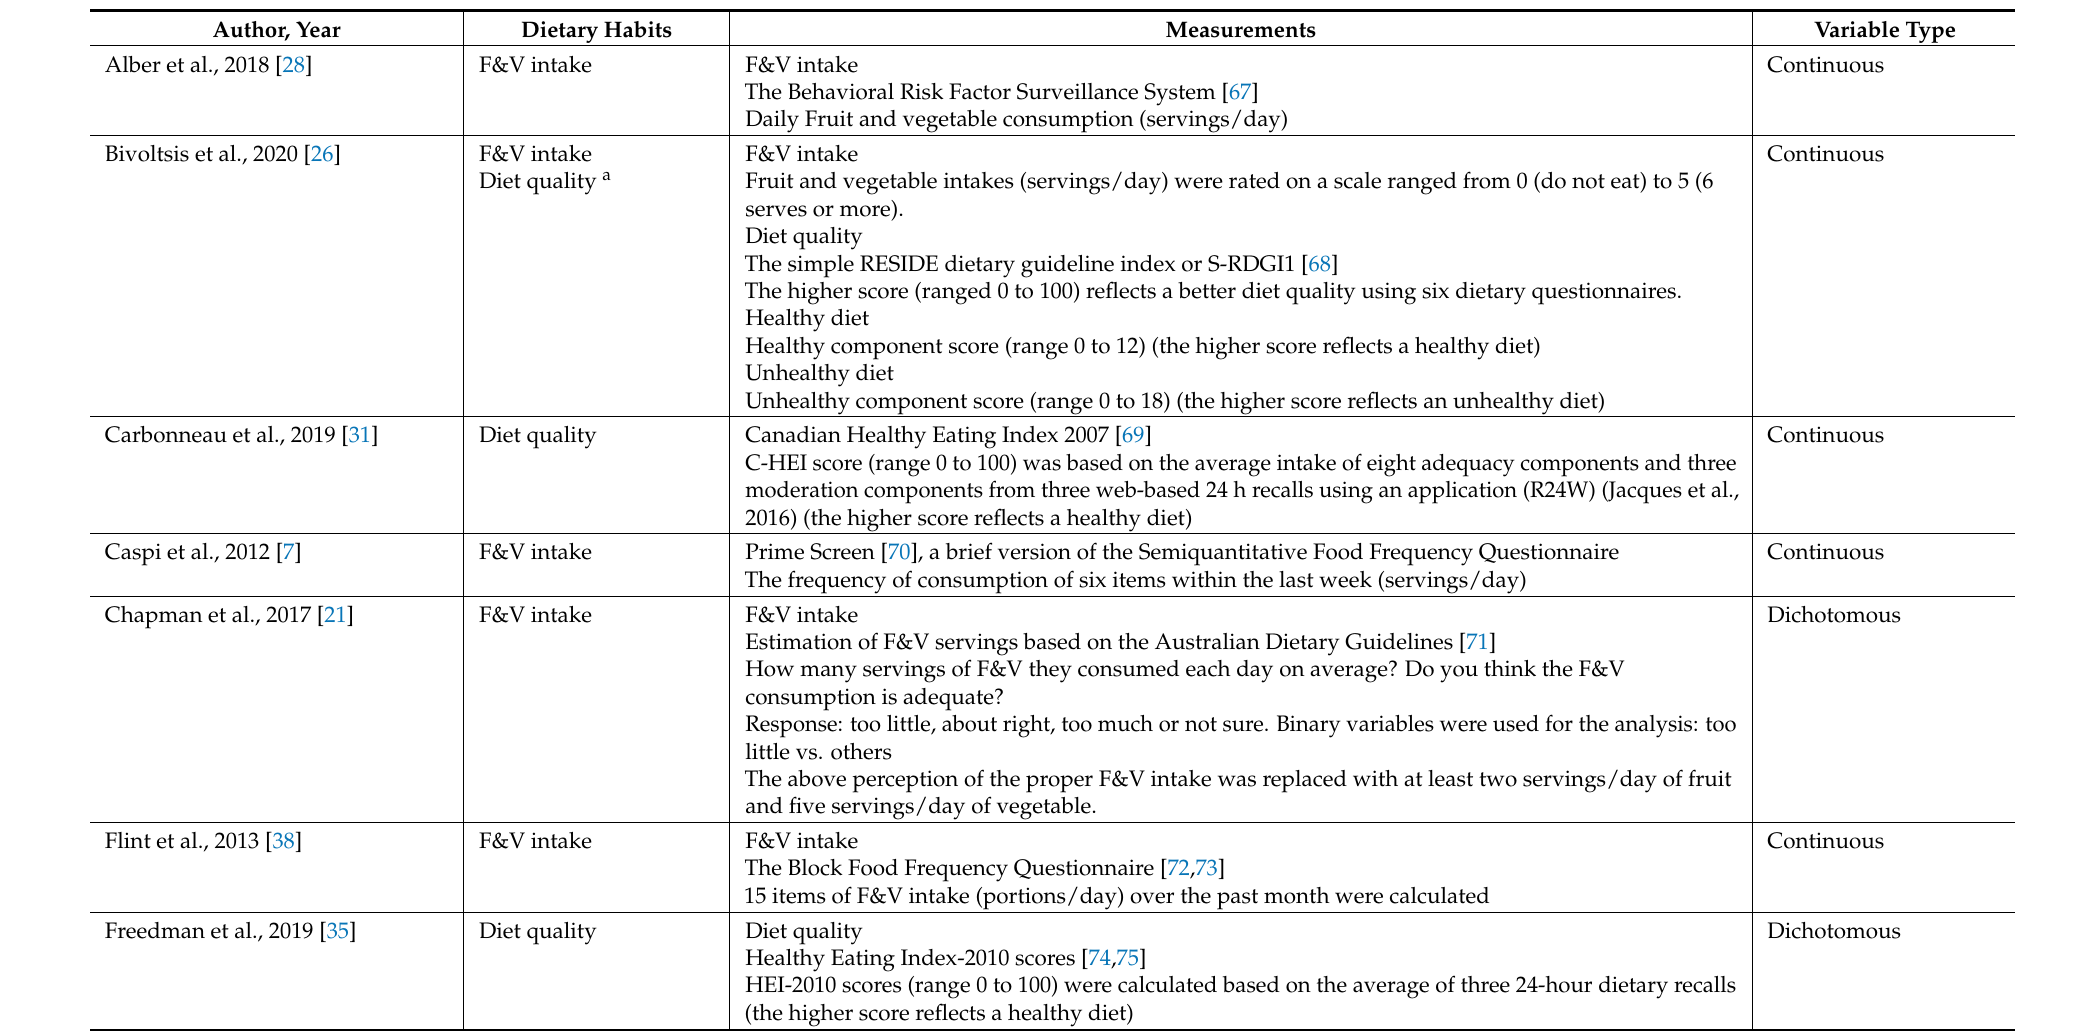
Table 3. Measurement tools of dietary